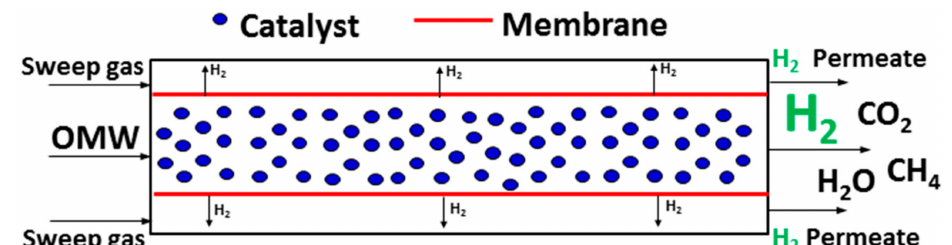
Figure 16. Scheme of the operation of the